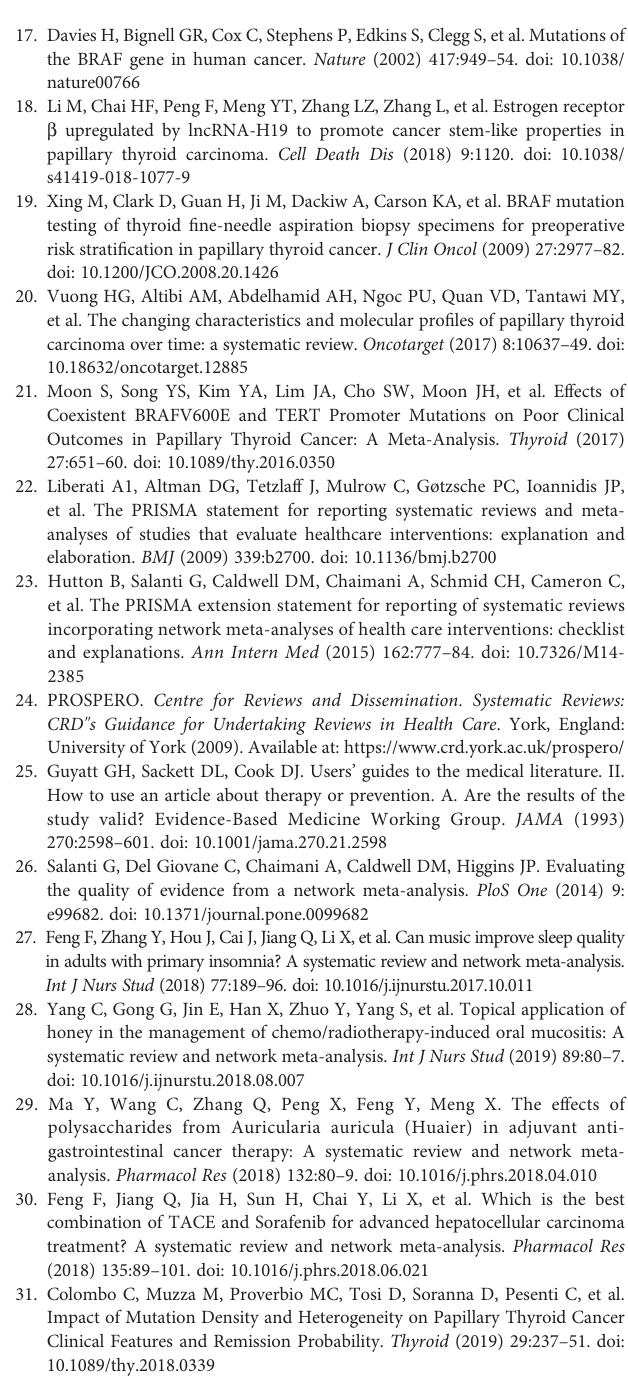
SUPPLEMENTARY FIGURE 2 | Funnel plot for the lymph node metastasis outcome in TC. SUPPLEMENTARY FIGURE 3 | Inconsistency plot for the extrathyroidal extension outcome in TC. SUPPLEMENTARY FIGURE 4 | Inconsistency plot for the lymph node metastasis outcome in PTC.